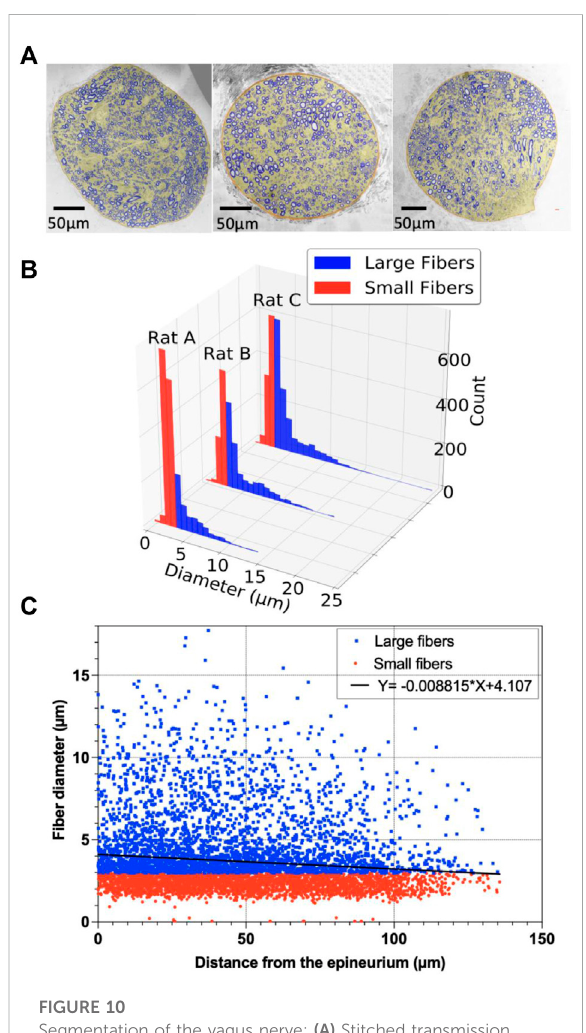
FIGURE 10 Segmentation of the vagus nerve; (A) Stitched transmission electron microscope (TEM) image (magni fi cation: ×300) of the cervical vagus nerve of adult Wistar rats and MATLAB segmented vagus nerve overlay on the top; (B) Histogram of large and small fi bers for rats A – C; (C) Scatter plot of the myelinated fi bers with the diameter (µm) as a function of distance (µm) from the epineurium ofthevagusnerveforratsA – C,andthepointestimate of the slope of the regression model.